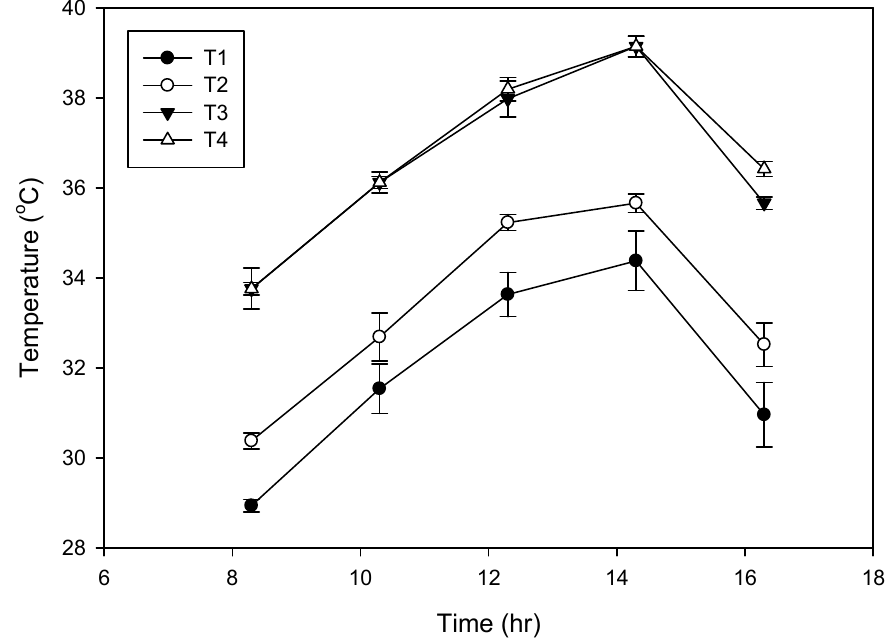
Figure 6. Mean diurnal temperature ( n = 3) of the coconut inflorescence enclosed in transparent chamber with temperature treatments. T1, ambient; T2, chamber control;T3, chamber with 3 ° C rise in temperature at an average relative humidity (RH) of 55 ± 5%; T4, chamber with 3 ° C rise in temperature at a mean RH of 65 ± 5% during April 2018. Bars on the lines indicate mean ± SD (standard deviation).